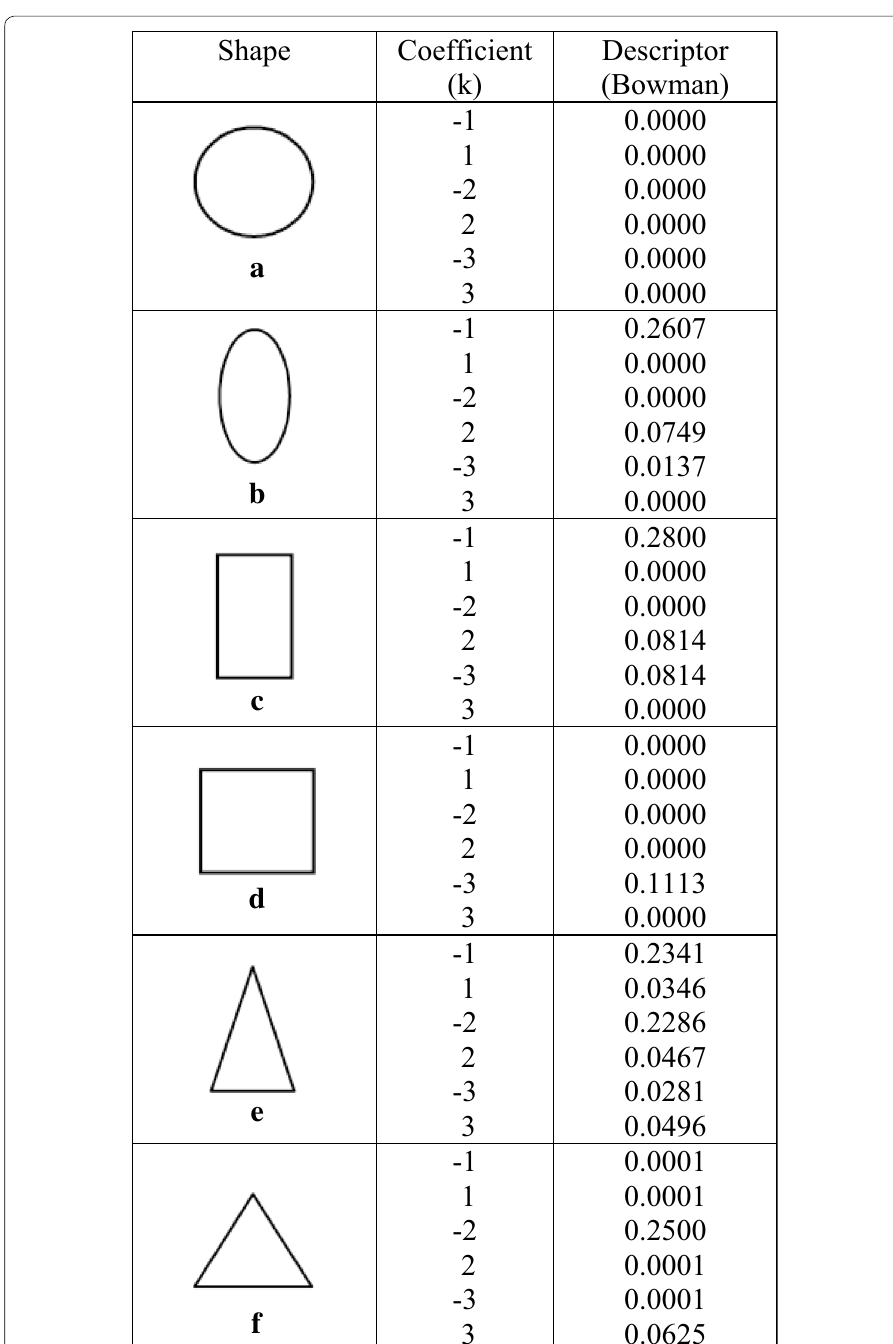
Fig. 4 General shapes used to investigate Fourier shape descriptors for morphological description: Elongation, 2 Triangularity, 3 Squareness, l Asymmetry, 2 s Order Elongation, − − + + Triangularity Bowman et al.